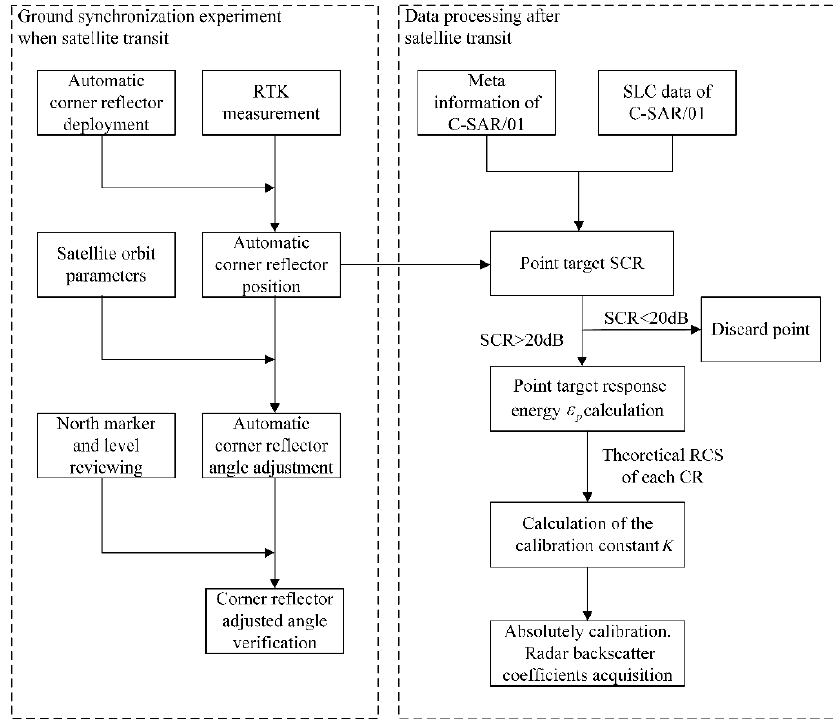
Figure 7. Flow of radiometric calibration based on point targets.